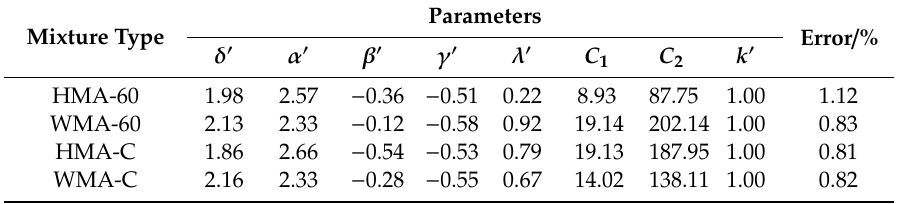
Figure 3. Master curve of storage modulus and loss modulus. Solving equation (11) we can get the generalized model parameters of storage compliance and loss compliance master curve, and the corresponding parameter results are shown in Table 6. Figure 4 shows the master curves of the storage compliance and loss compliance for the types of mixtures.